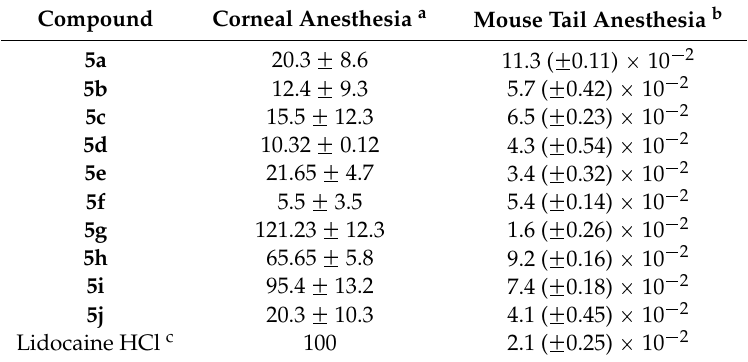
Table 5. Local anesthetic evaluation of the target compounds in the rabbit corneal and mouse tail anesthetic